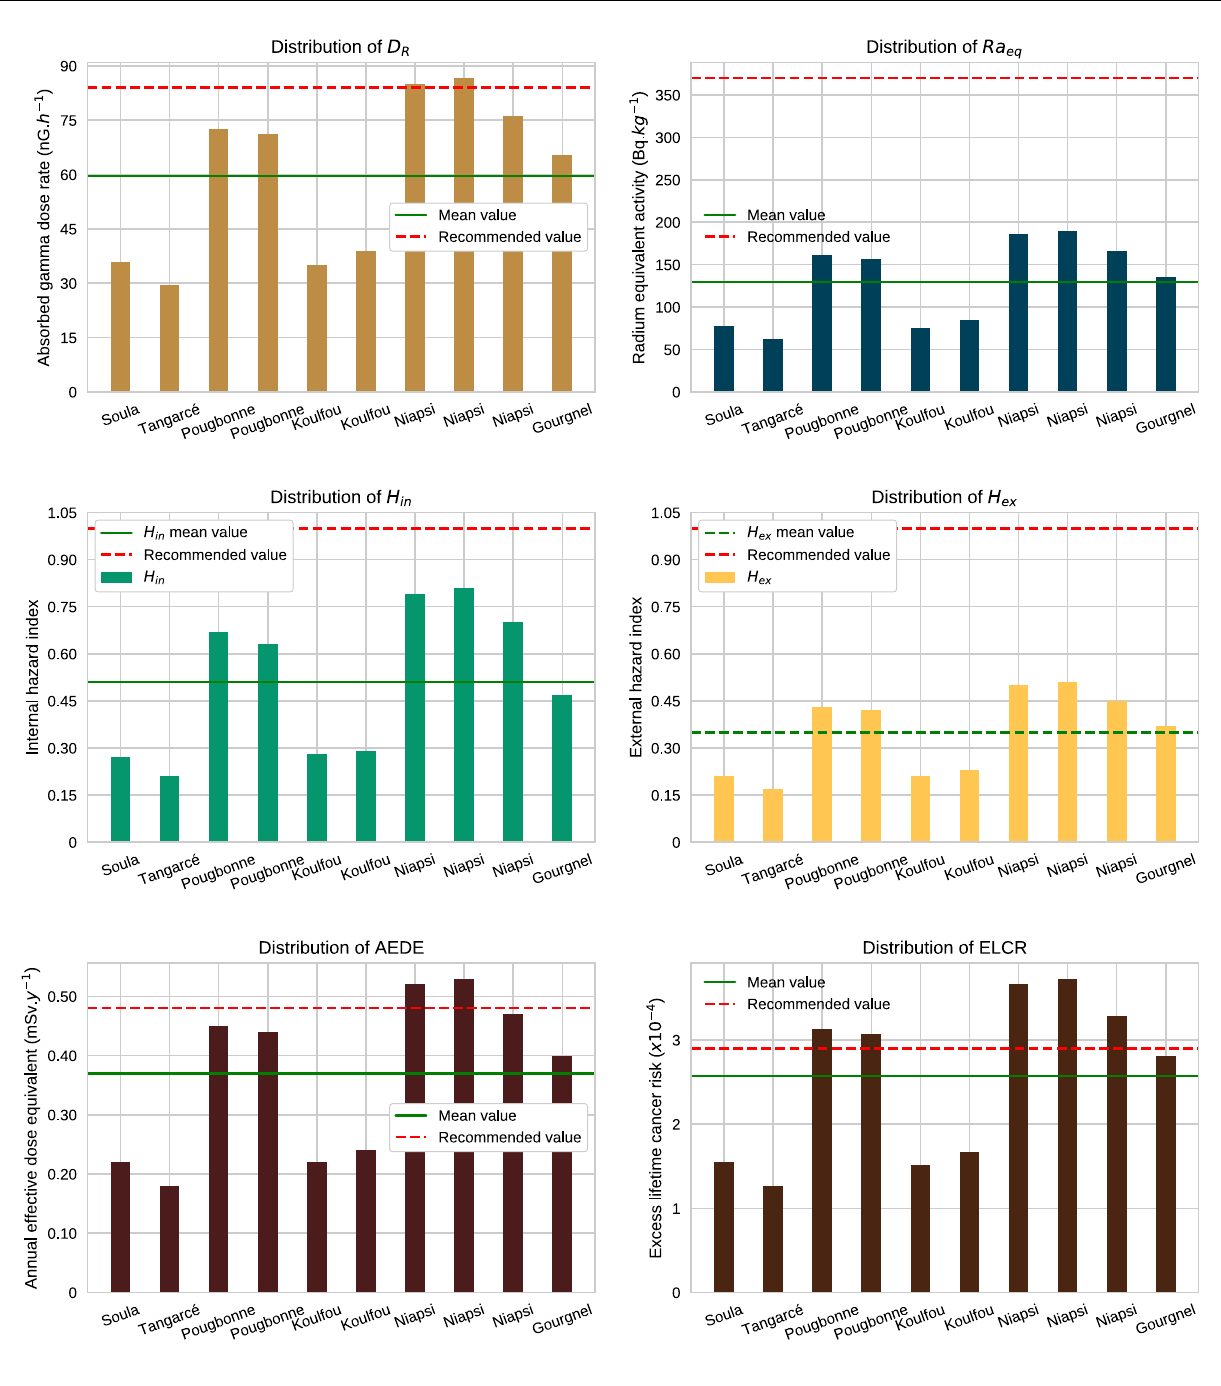
Fig. 3 Distribution of radiological parameters for a depth of